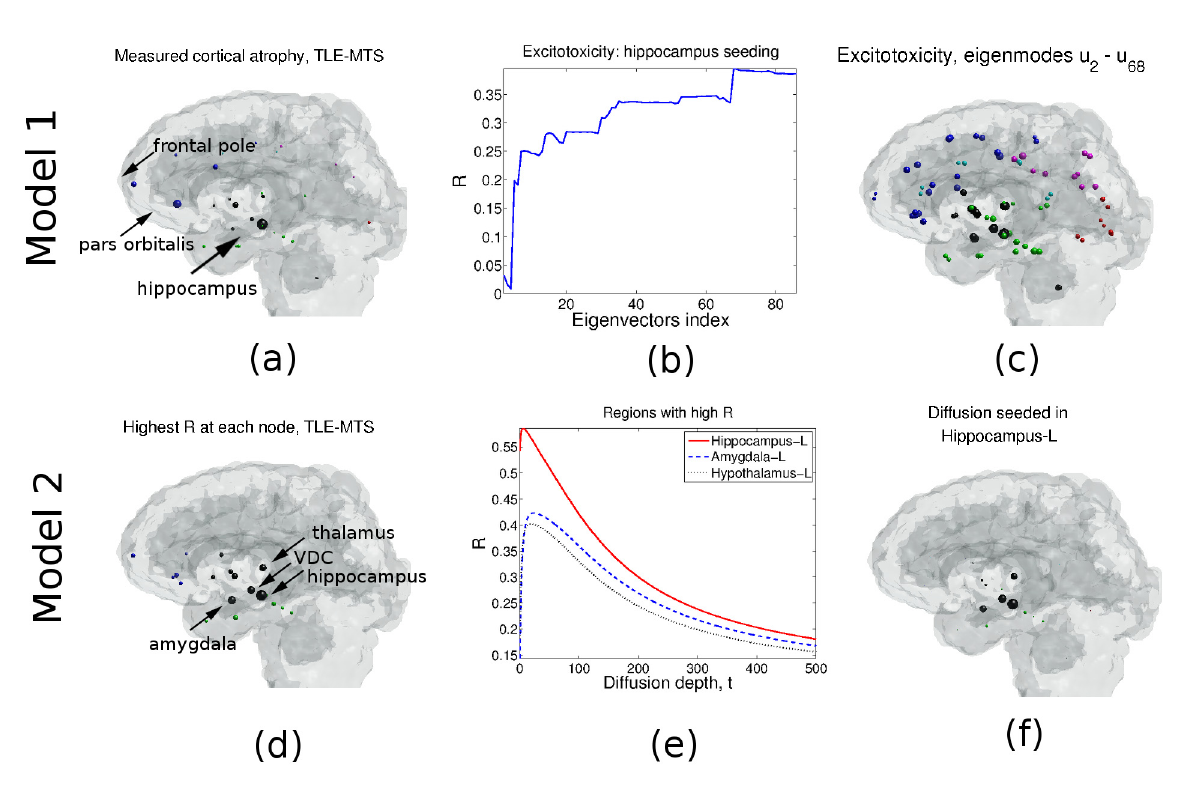
Fig 1. (a) TLE-MTS atrophy distribution. As expected, the hippocampus has the highest atrophy, consistent with TLE-MTS. (b) Pearson correlation R between Φ 1 and measured atrophy vs. the number of eigen-modes used. Peak R is reached when eigen-modes u 2 – 68 are used. (c) Atrophy distribution estimated using Model 1 using eigen-modes u 2 – u 68 . Model 2: (d) Correlation R obtained when each node is seeded (model Φ 2 ). The highest R is obtained when the hippocampus is seeded. (e) R vs. graph diffusion depth. Hippocampus seeding leads to the highest R is obtained at t = 5.56, followed by amygdala and the hypothalamus. (f) Estimated TLE-MTS atrophy obtained from Model 2 when the hippocampus is